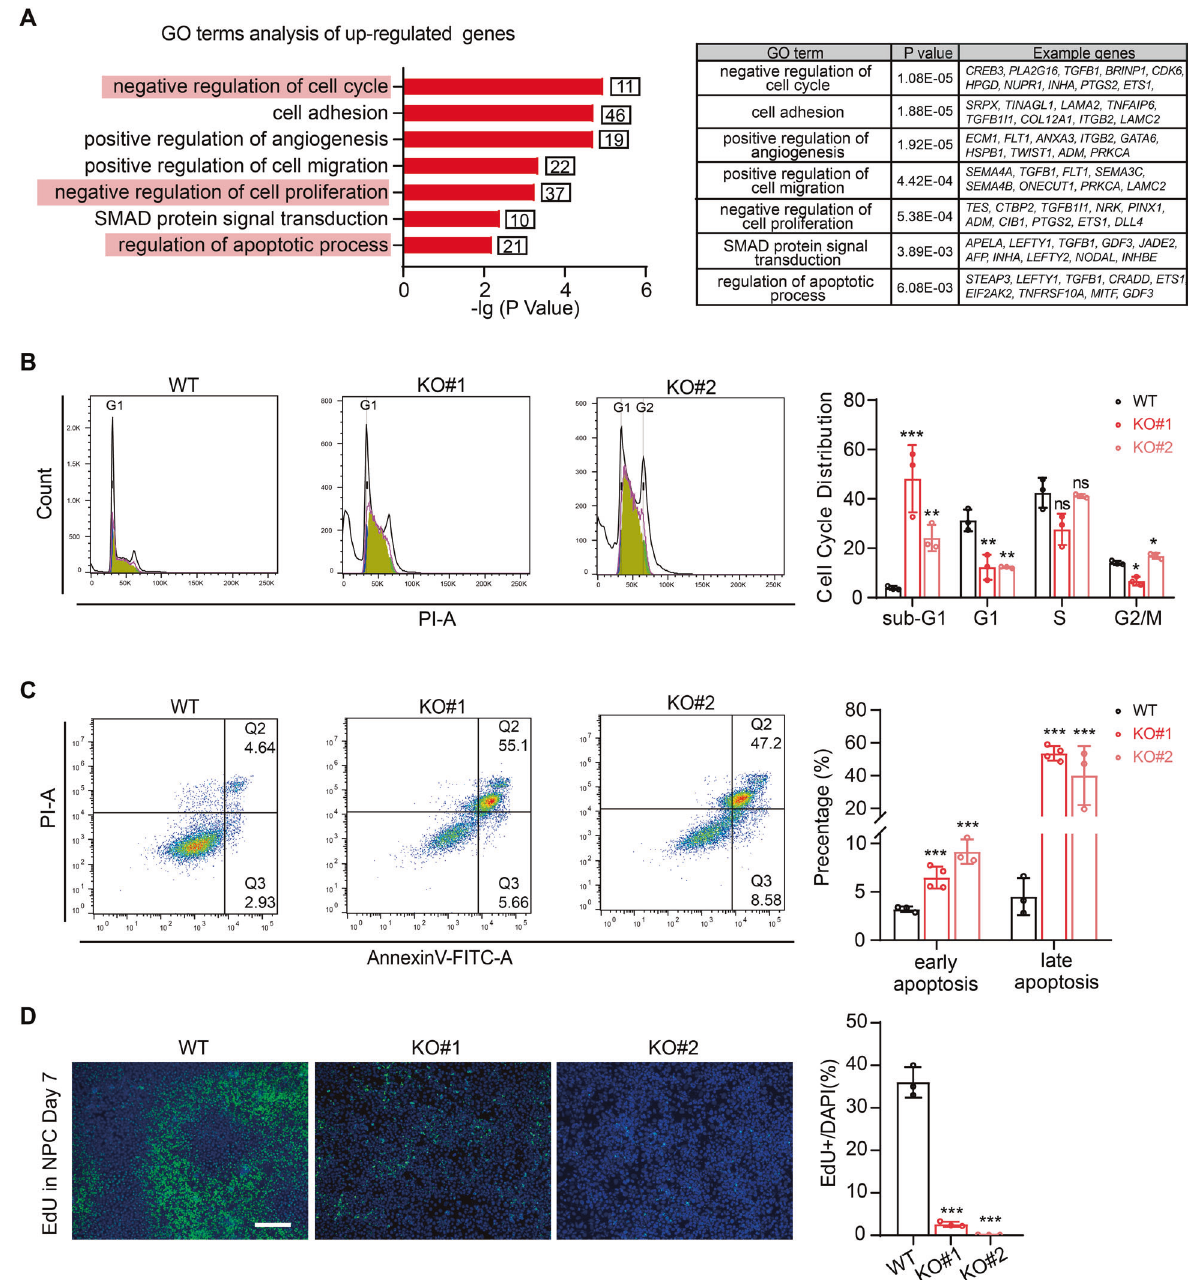
Fig. 6 CHD8 knockout induces dramatic apoptosis in neuroectoderm progenitor stage. A GO analysis of upregulated genes in CHD8 knockout neuroectoderm progenitors (log 2 (fold-change) > 1, P < 0.05). B Cell cycle analysis using PI staining in wildtype and CHD8-KO neuroectoderm progenitors by FACS. The populations of different phases were calculated in FlowJo (v10.4.0) ( n = 3). C AnnexinV/PI assay in wildtype and CHD8-KO neuroectoderm progenitors by FACS ( n = 3). D Representative EdU staining image of wildtype and CHD8-KO neuroectoderm progenitors ( n = 3). Scale bar = 200 µm. The error bars represented the mean ± SD and the signi fi cance level was calculated by Student ’ s t -test (two-tailed, equal variance) (ns means not statistically signi fi cant, * P < 0.05, ** P < 0.01, *** P < [3, 38, 39]. Using the CHD8 knockout human ESCs, we found the neuroectoderm differentiation. CHD8 knockout resulted in severe complete depletion of CHD8 has no signi fi cant effect on the defect of activation of neural lineage genes that not only expression of pluripotent markers, however, the ESCs with CHD8 explained the blocked neuroectoderm differentiation, but also knockout exhibit altered cell cycle progress with a shortened G1 caused signi fi cant derepression of apoptosis-related genes during phase, eventually resulting in modestly promoted cell proliferation neurogenesis, which led to massive cell death in NPC stage (Fig. 2). Similarly, the Chd9 knockdown mouse ESCs also show a (Fig. 7E). modestly shortened G1 phase and promoted cell proliferation CHD8 belongs to chromodomain-helicase DNA-binding (CHD) [40]. However, Chd1 , Chd2 or Chd7 seems not to regulate the cell family proteins, which act as chromatin remodelers functioning in cycle or proliferation, but both Chd1 and Chd2 are required for the the regulation of stem cells maintenance and differentiation